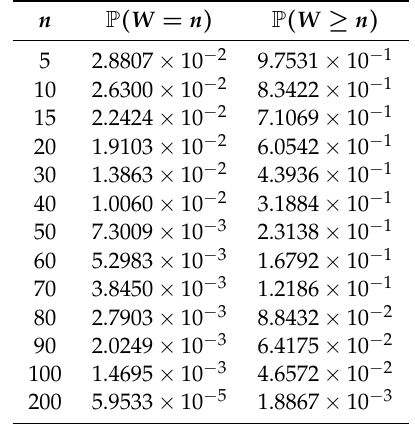
] , j = 1, . . . ,10 and unconditional mean E [ W ] for j